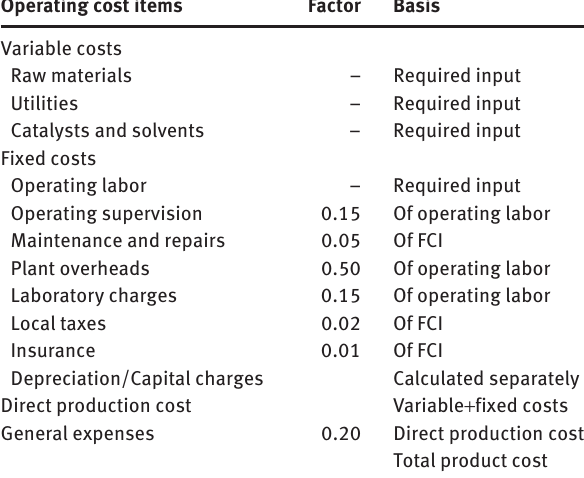
Table 4 Operating cost determination based on factorial estimates (as given by Peters et al. and Sinnott et al. [43,